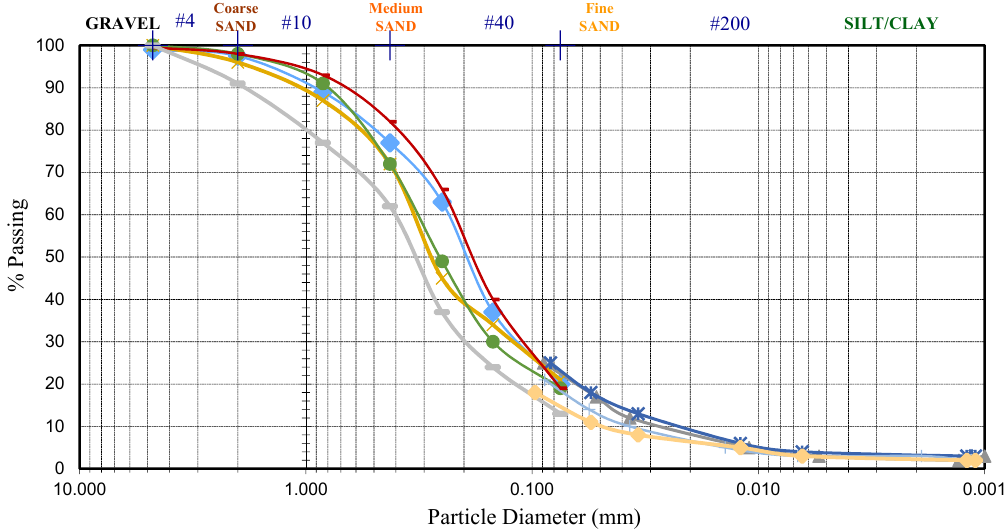
Figure 2. The particle size distribution of index soil sample collected from the Bagan Lalang beach site.